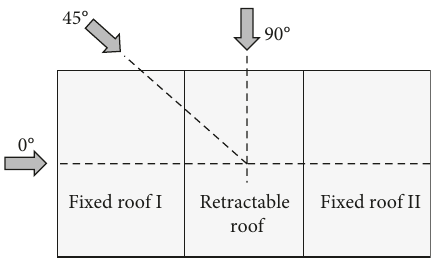
Figure 9: Sketch of the incidence angle of